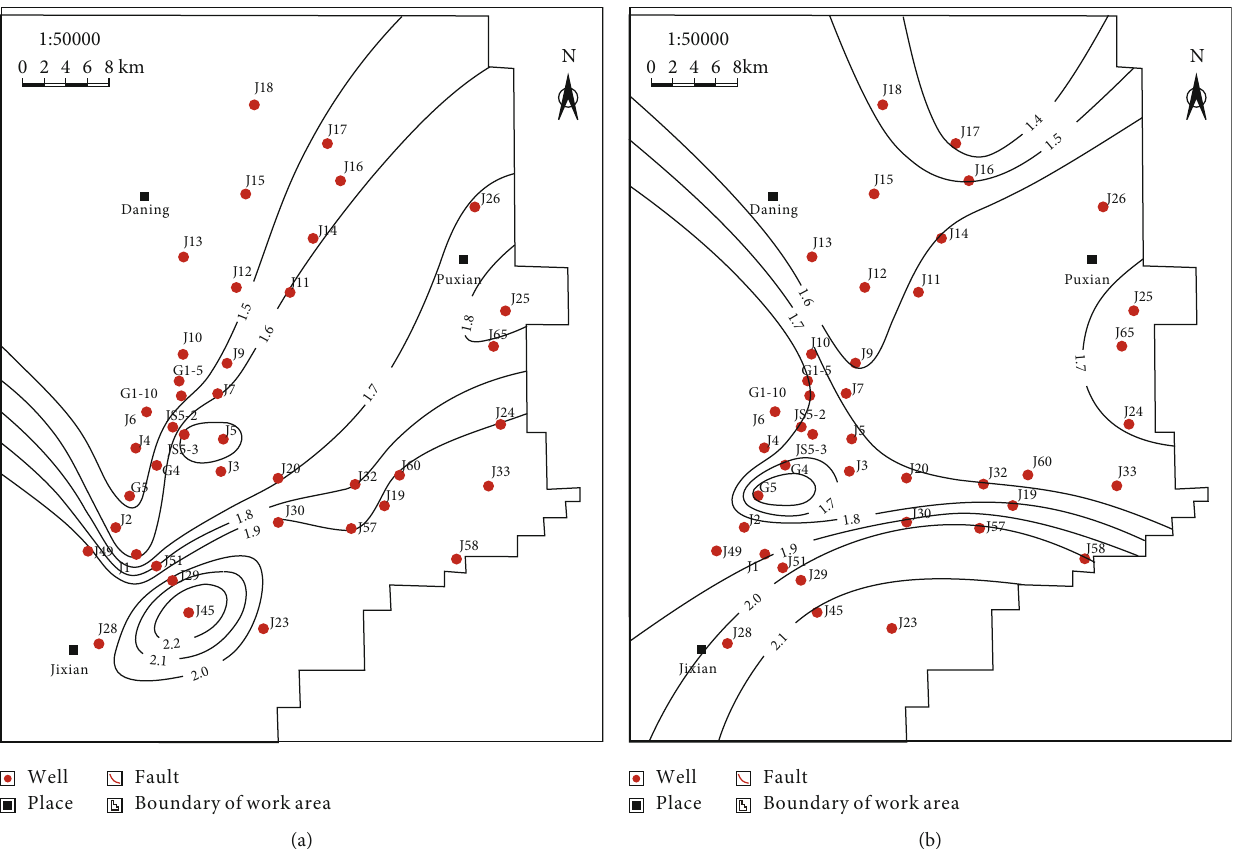
Figure 6: The contour map of vitrinite re fl ectance (Ro) of the mud (shale) stone reservoirs in the study area. (a) Shanxi Formation; (b) Taiyuan